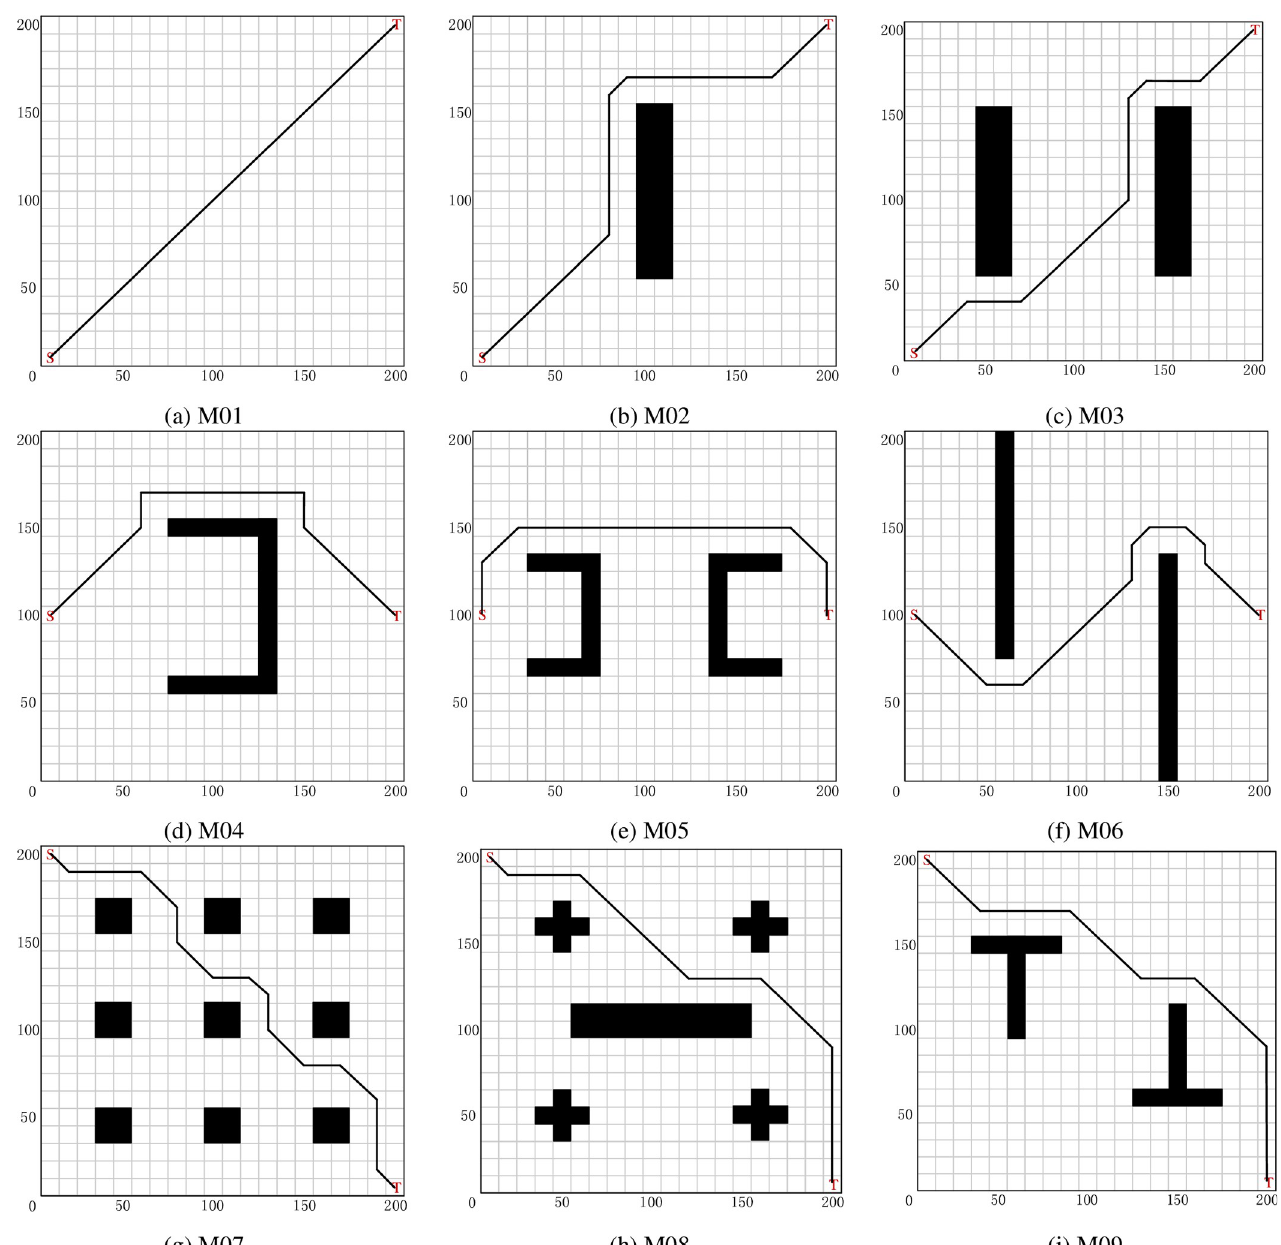
Fig 5. Safe path planning (solution) for MR in different test environments (Each map shows the best path obtained by the SSQL algorithm, S is the starting point and T is the target point). https://doi.org/10.1371/journal.pone.0275100.g005 actual needs. When the mobile robot aims to reach the target point as soon as possible, the short path planning mode of SSQL can be used to make the mobile robot reach the target with the shortest path length and turning angle. When the purpose of the mobile robot is to avoid collision with obstacles, the safe path mode can be adopted, and the mobile robot will plan the feasible path away from the obstacles. The combination of the two modes can be better applied in the working environment according to the actual use of mobile robots.